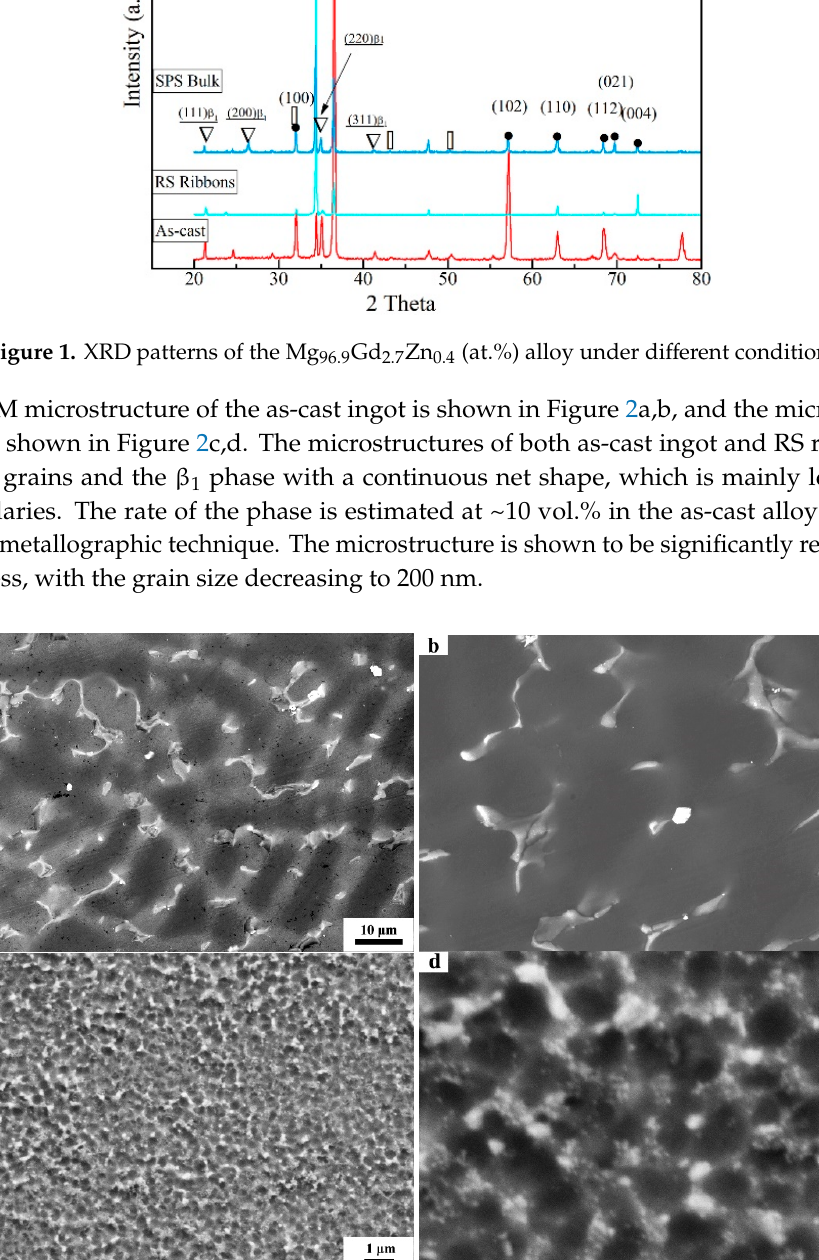
Figure 1. XRD patterns of the Mg 96.9 Gd 2.7 Zn 0.4 (at.%) alloy under different conditions.